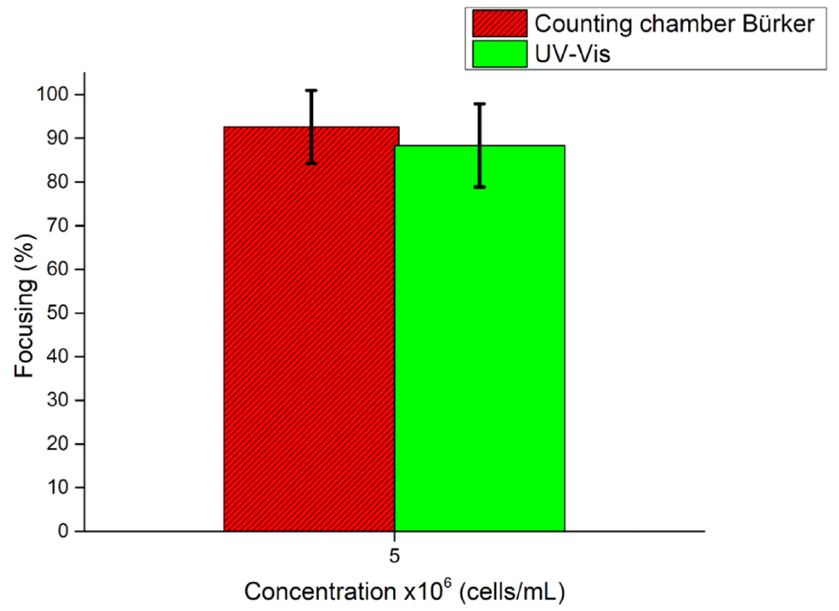
Figure 12. Focusing performance of the BAW device from Bürker counting chamber analysis and UV–Vis characterization. HL-60 cells concentrated at 5 × 10 6 cells/mL were injected at 3 µL/min when 50.59 Vpp was applied to the transducer, while the device was actuated at its resonance frequency of 4.623 MHz.